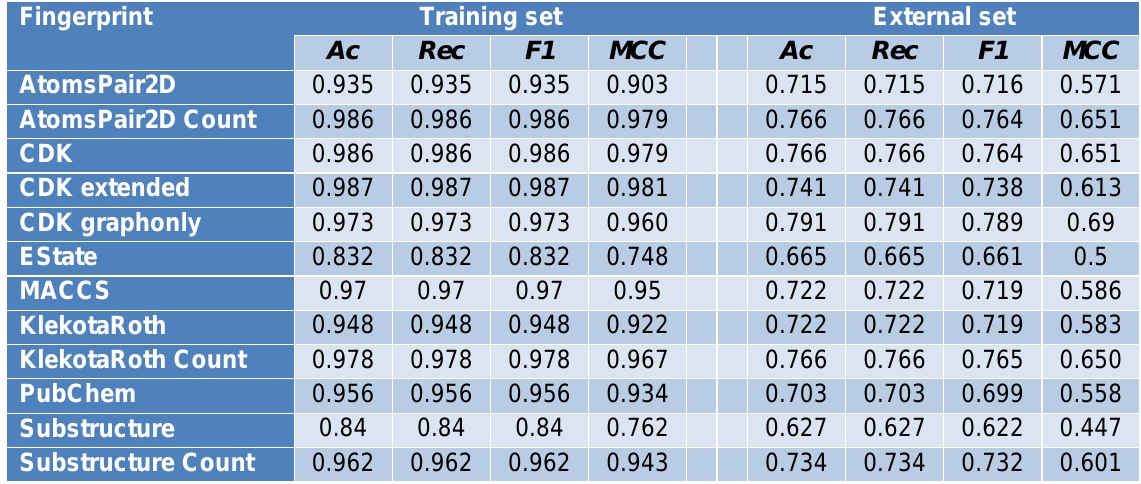
Table 4: Summary of model performance built using 12 sets of molecular fingerprints using